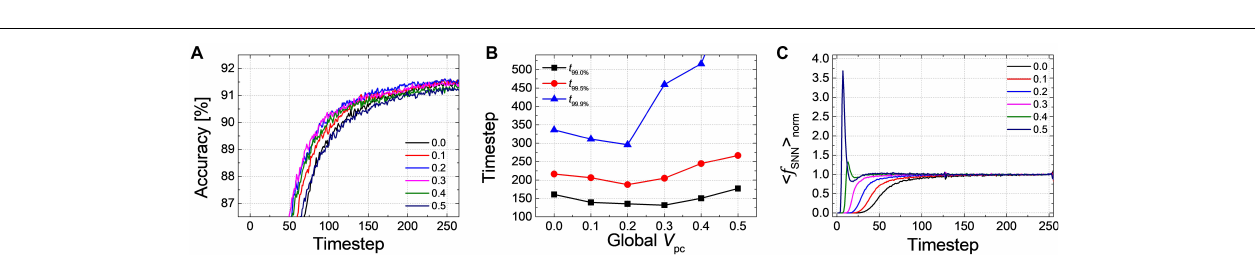
FIGURE 4 | Correlation plots of Net 1 at 50, 100, and 150th timesteps for the global V pc of (A) 0.0 and (B) 0.5. The latency occurs in early timestep, and its effect gradually disappears along with the simulation time. Latency reduction effect is more noticeable when the global V pc of 0.5 is applied.